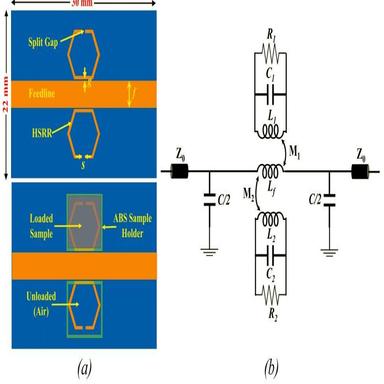
(a) Layout of the proposed HSRR sensor and its (b) equivalent circuit model.